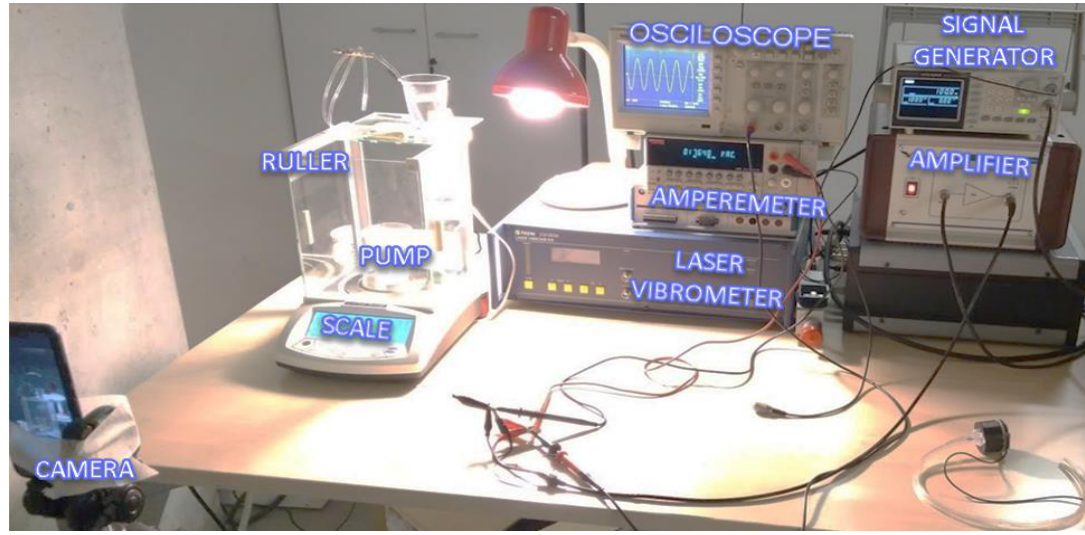
Figure 12. Experiment setup and architecture.